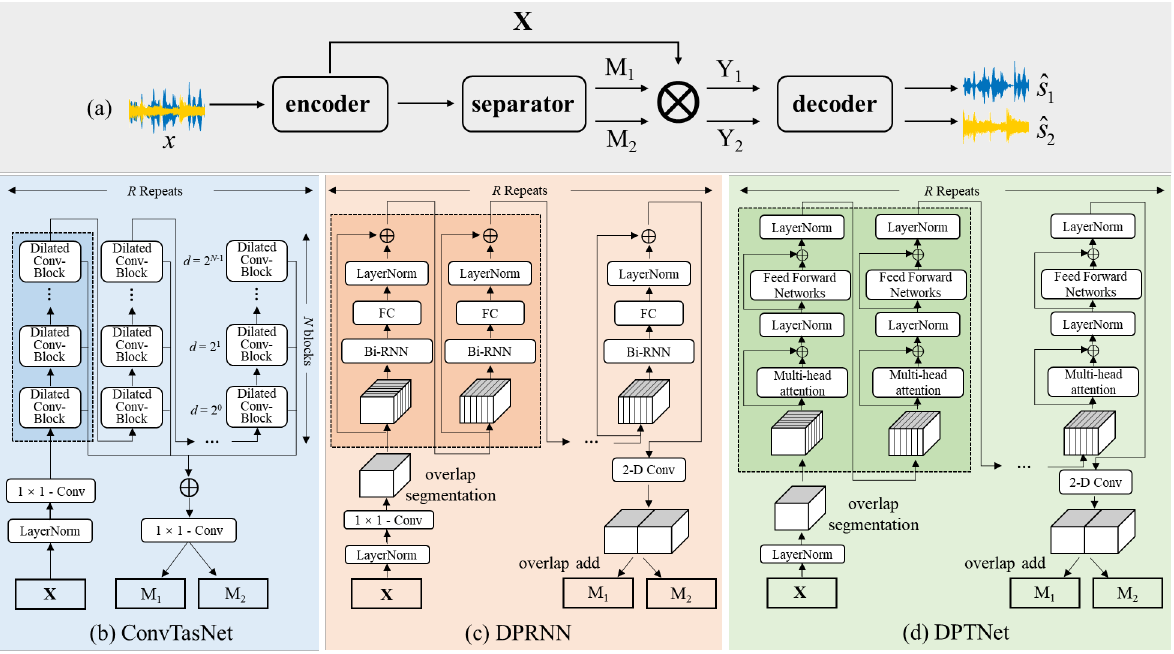
Figure 1. The structures of three networks, where ( a ) indicates the unified framework for source separation networks: encoder-separator-decoder, ( b , c , d ) indicate the separator in ConvTasNet [15], separation networks: encoder-separator-decoder, ( b – d ) indicate the separator in ConvTasNet [15], DPRNN [22], and DPTNet [23], respectively. DPRNN [22], and DPTNet [23],